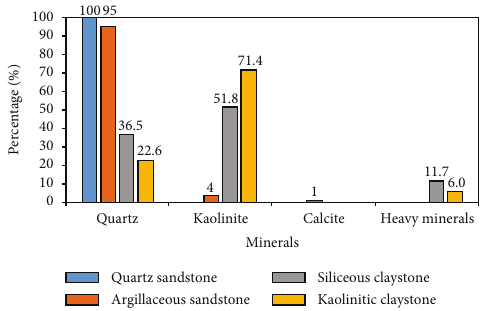
Figure 2: Mineral composition of four core samples.